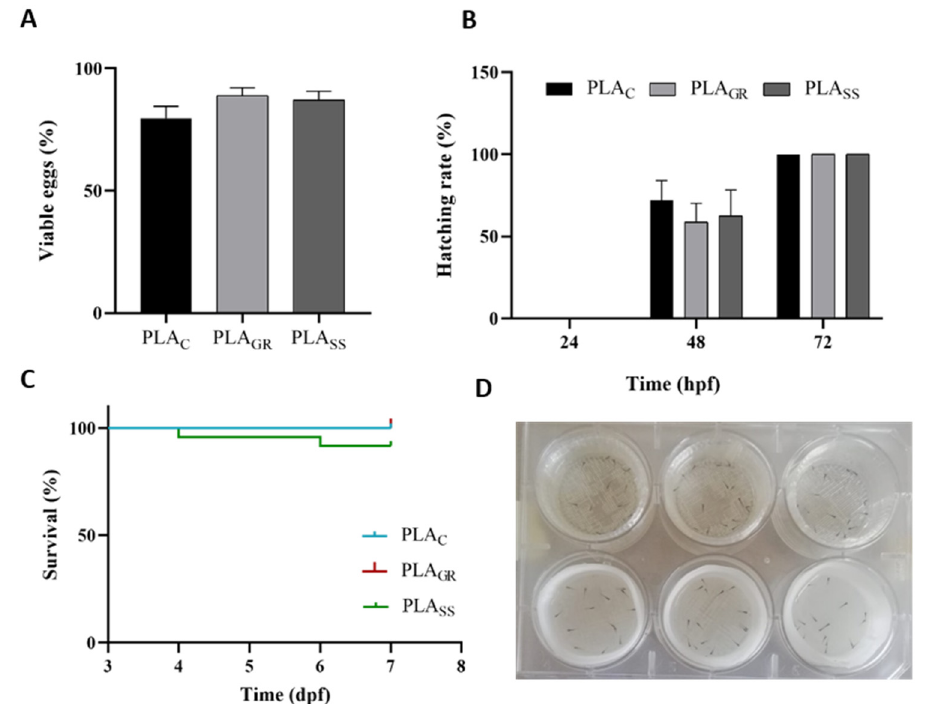
Figure 10. Viable embryos (%) after 24 h after exposure to PLA GR , PLA SS and PLA C ( A ); hatching rate (%) at 24, 48 and 72 hpf ( B ); survival rate of larvae after 7 dpf (days post-fecundation) ( C ); larvae at 3 dpf on the PLA C (above) and PLA SS (below) well samples ( D ). Results are represented as the mean ± standard error.